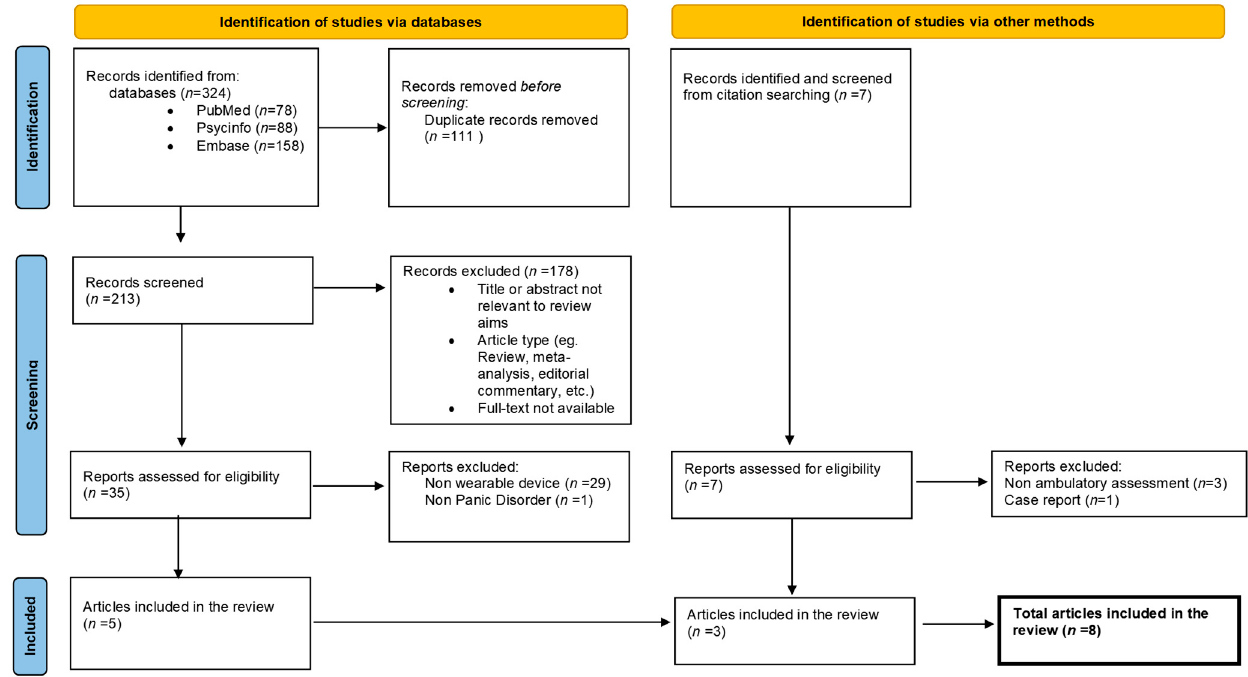
Figure 1. PRISMA flow diagram .